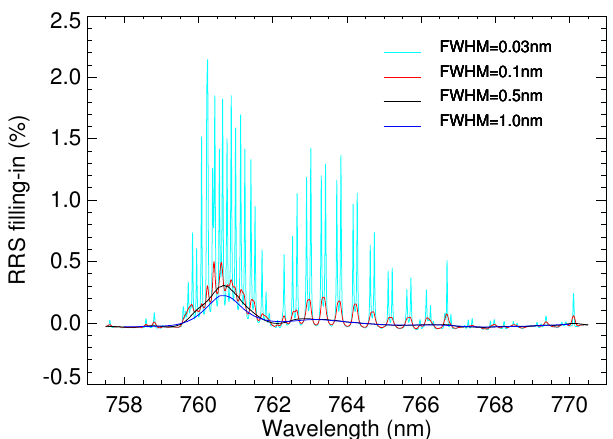
Fig. 11. Similar to Fig. 4 but SZA = 70 ◦ .